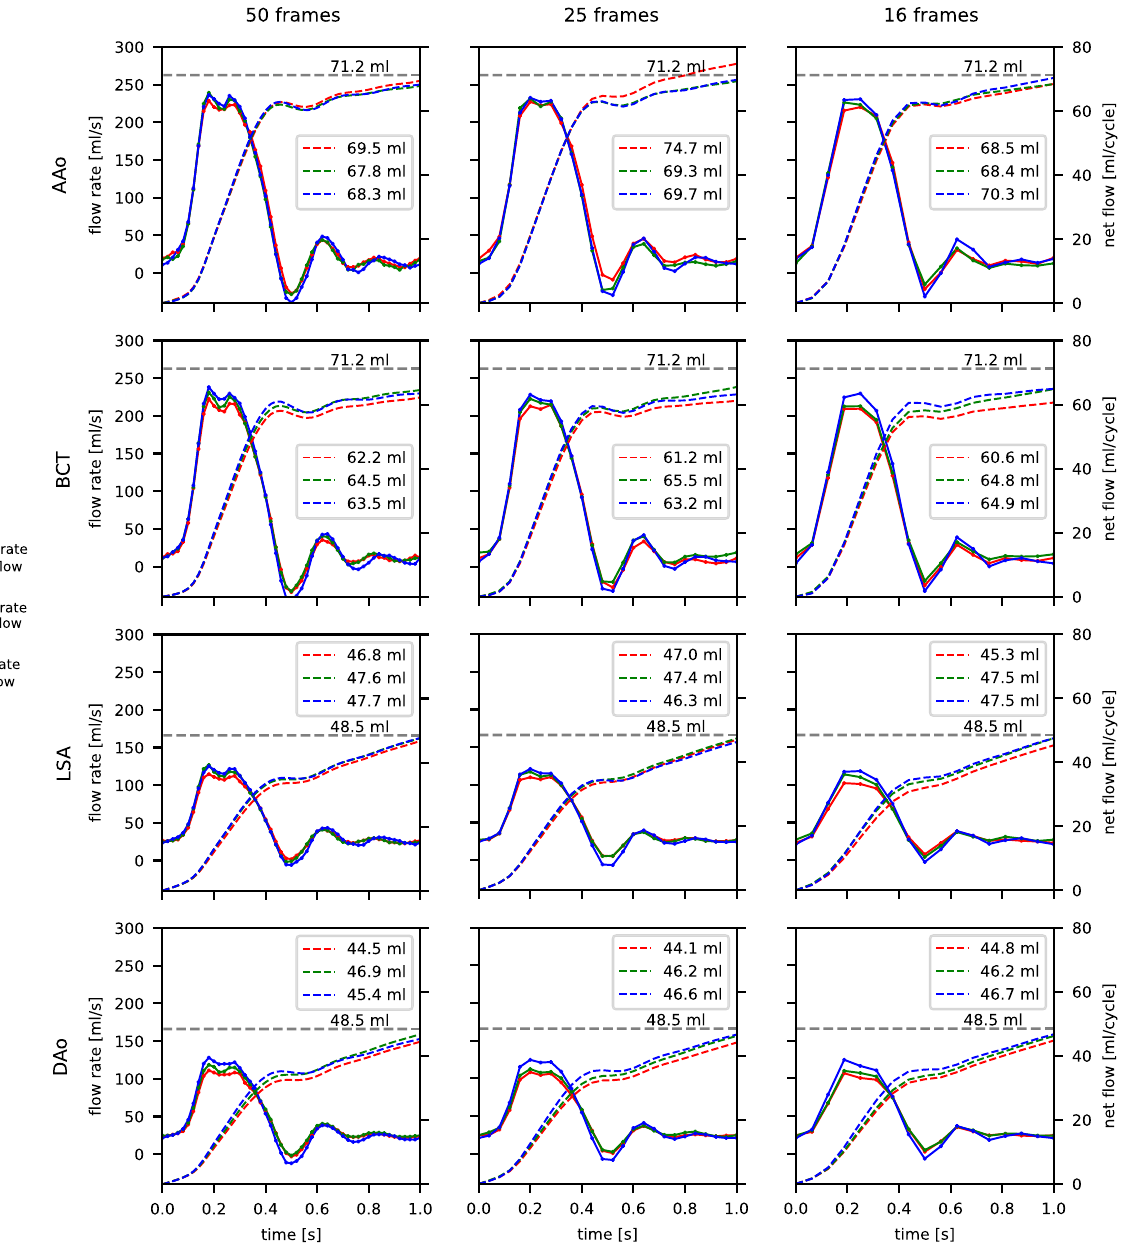
Figure 6. 4D-flow derived flow rate waveforms (left ordinates) and cumulative net flow (right ordinates) at four landmarks (Fig. 1g) and three different temporal sampling rates. Grey horizontal lines show the expected net flow according to the programmed inflow (71.2 mL/cycle) for the AAo and BCT slices, and measured (via ultrasonic transducer during setup tuning) DAo branch outflow (48.5 mL/cycle) for the LSA and DAo slices. Plots created using Python (v3.6, https:// www. python.